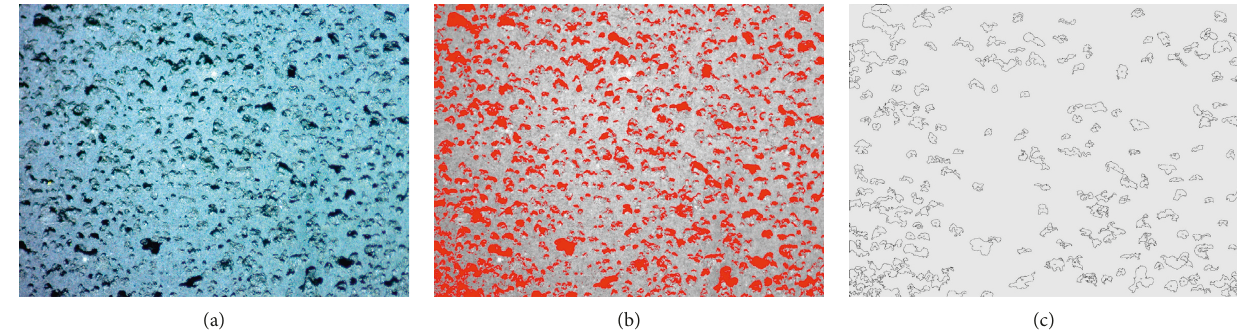
Figure 6: Steps of image analysis. (a) Cross-sectional image; (b) grayscale 8-bit image adjusted by the threshold option; (c) drawing of the pores.